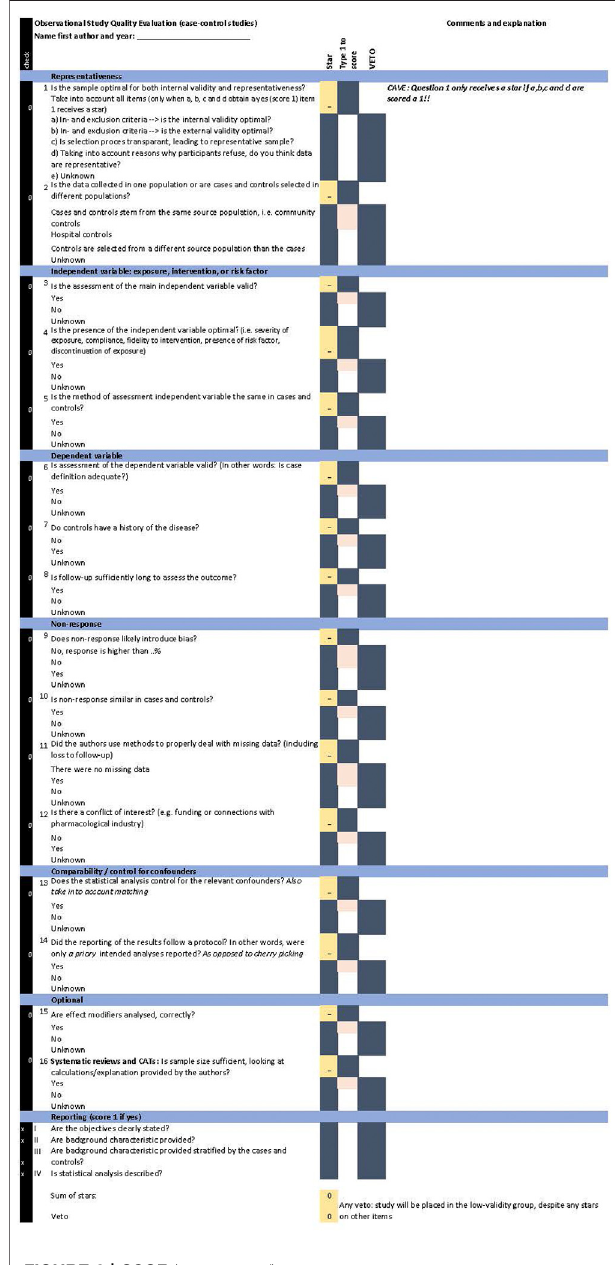
FIGURE 2 | OSQE (case –